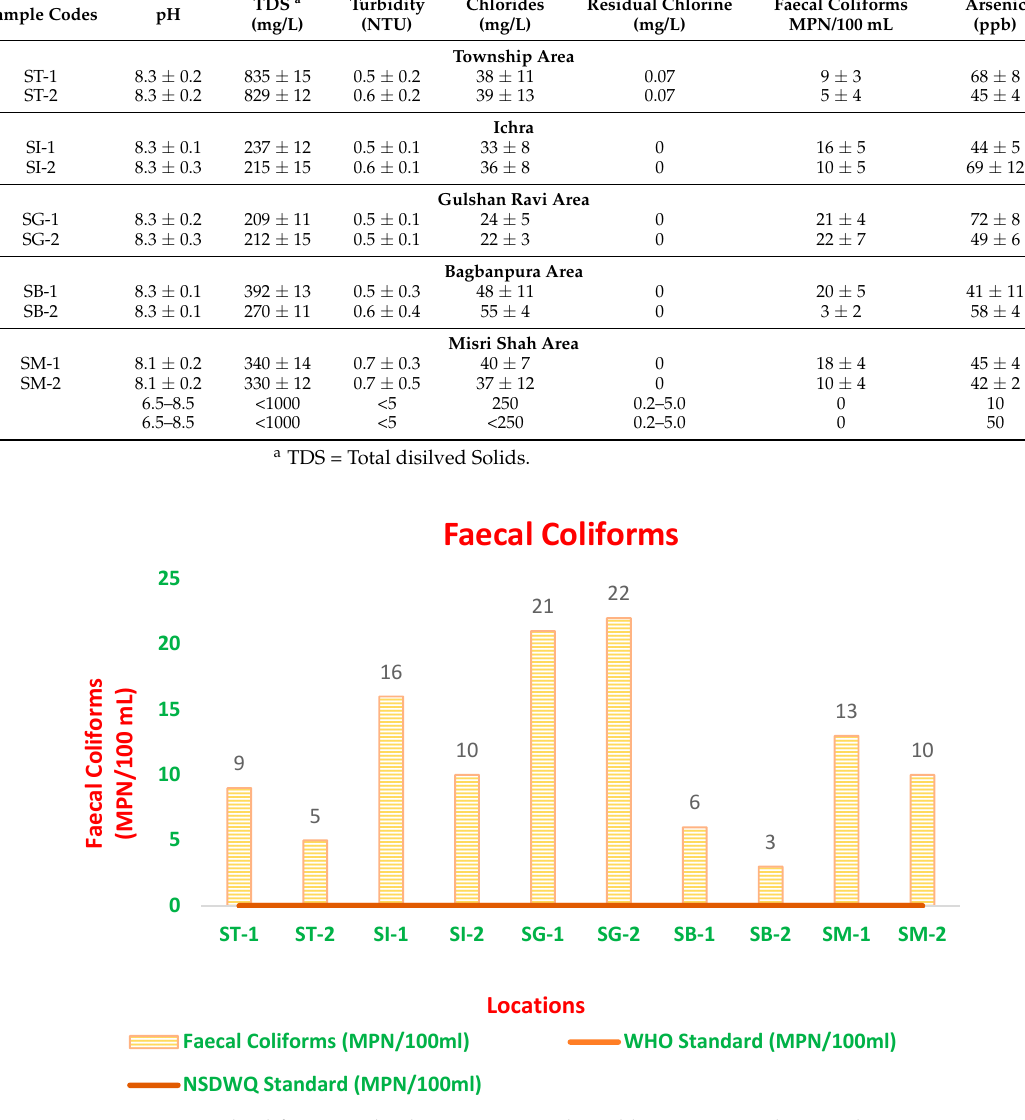
Figure 4. Arsenic in drinking water at selected locations, of Lahore, Pakistan. 2.1.2. Human Health Risk Assessment Model The application of health risk assessment is also carried out to quantify the indi- vidual health risks in terms of As contamination in the water samples. The threshold limit for HQ was 1. If the HQ value increases more than the recommended limit, it can be harmful and may cause serious health effects [59]. Figure 5 shows that the HQ value of As lies between 0.86–1.39 with 40% of the samples having HQ values greater than 1 (Figure 5). This suggested that the population of Lahore (explicitly residing in the sam- pling locations) may be at a severe health risk threat from As contamination in drinking water [59]. Therefore, it is essential to search for novel methods that help treat As at household levels.